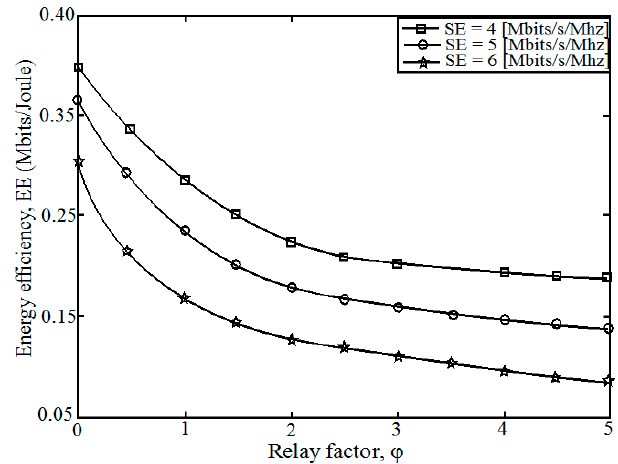
Figure 7. Representation of the EE when the relay power is taken into account in the CCRNs as a function of relay factor ϕ with different value of SE.